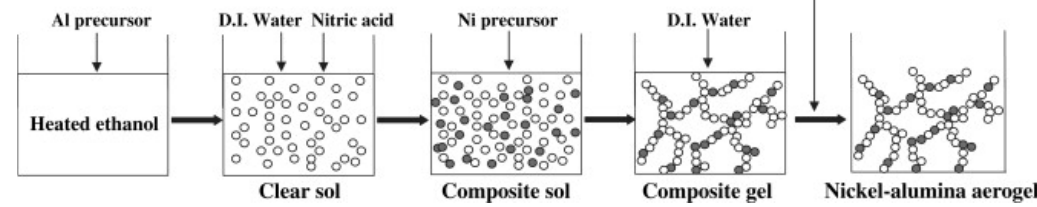
Figure 14. Procedure for the preparation of nickel-alumina aerogel catalyst by a single-step sol-gel method and subsequent supercritical CO 2 drying (Reprinted with permission from [68]. Copyright Elsevier, 2010).